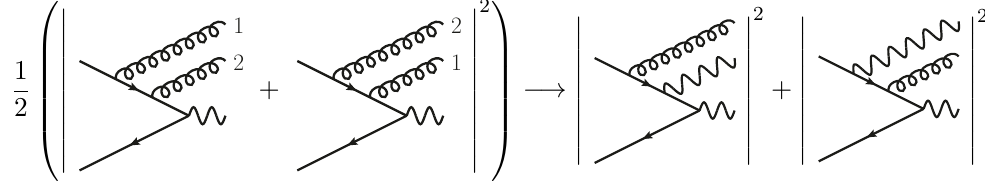
Figure 3. Contributions to the colour factor C 2